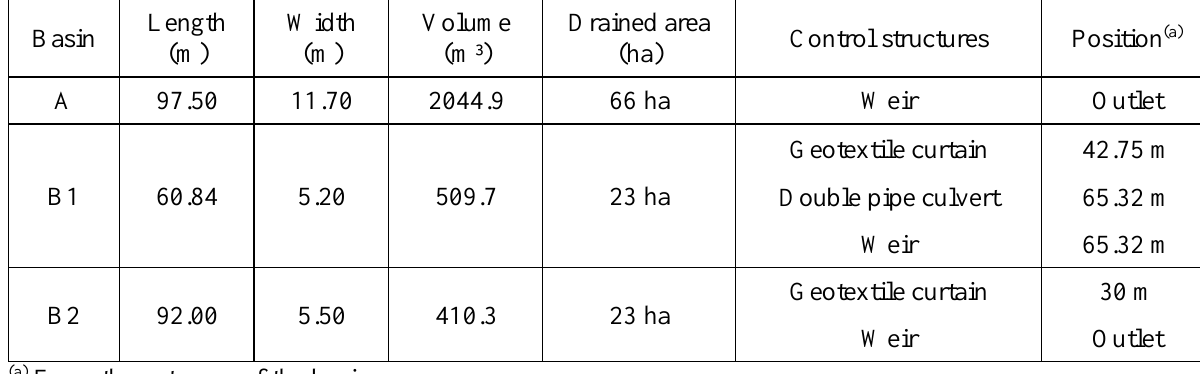
Table 1. Characteristics of the studied basins.